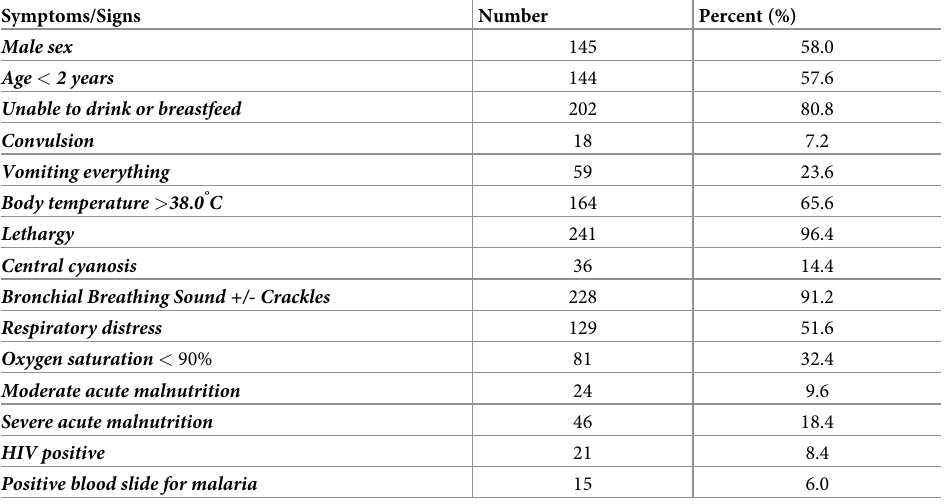
Table 1. Demographic information and clinical characteristics among 250 children with severe community acquired pneumonia admitted at BMC from October 2013 to February